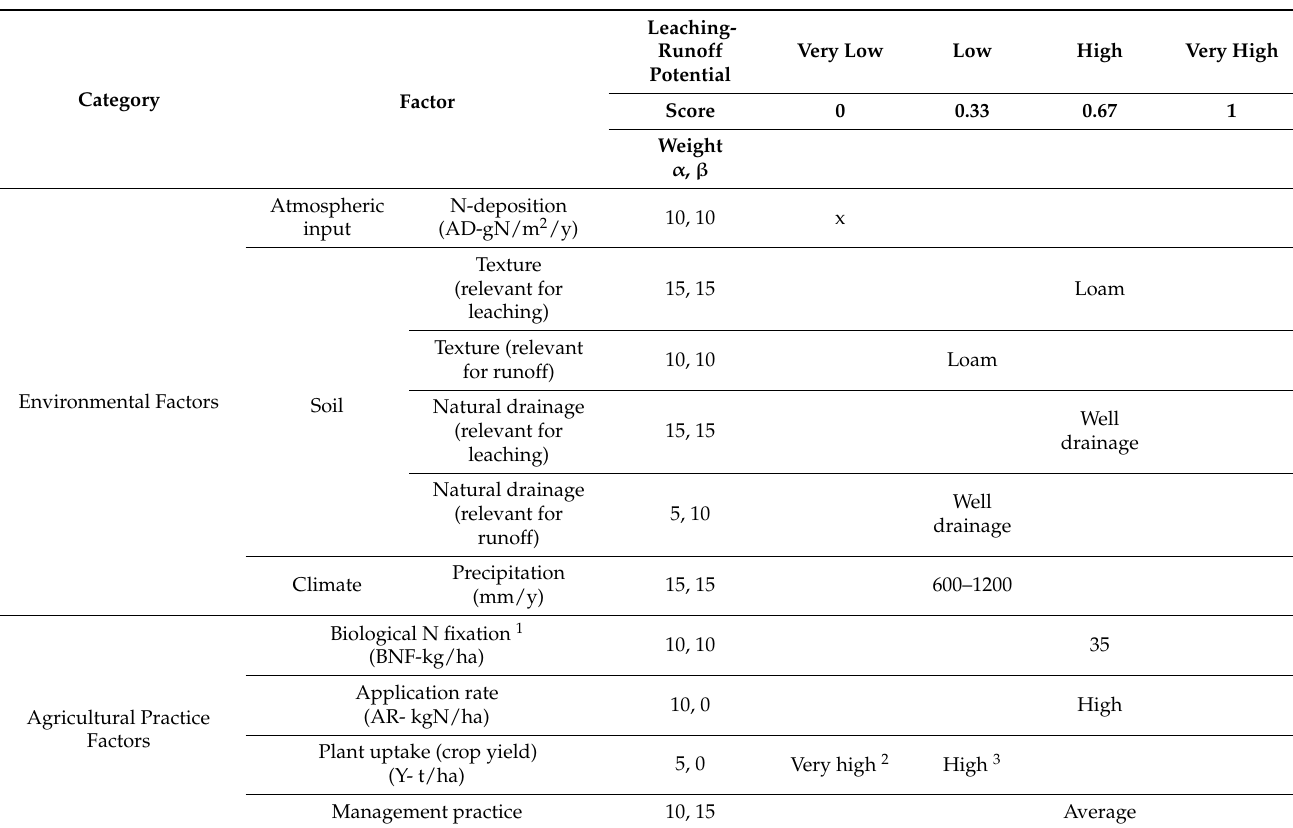
Table 1. Estimation of leaching/runoff fractions ( α and β ) based on environmental factors and agricultural practices specific to analysed plots. Source: Franke et al.